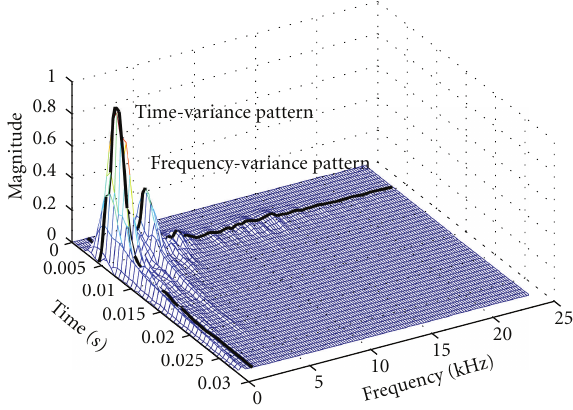
Figure 1: The time-frequency intersection pattern refers to the combination of the time-variance patter containing instantaneous powers (or their square roots) for all time frames and the frequency- variance patter with the instantaneous spectrum at power peak. (The time-variance pattern is illustrated as the line along with the